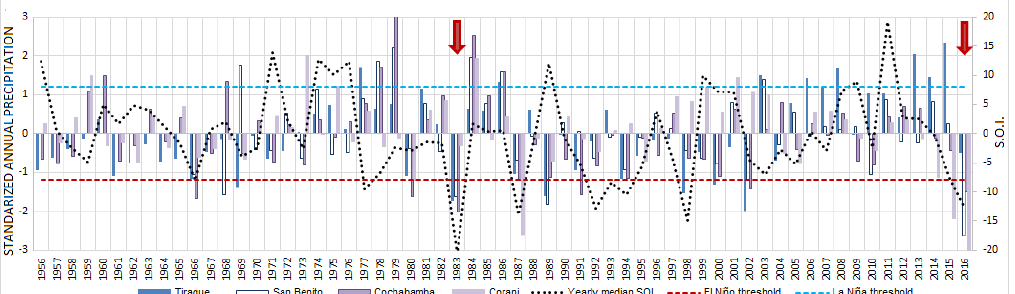
Figure 3. Normalized annual precipitation at Tiraque, San Benito, Corani and Cochabamba stations, and yearly SOI values. SOI values beyond the +8 or −8 limits mean that a strong La Niña or El Niño took place.